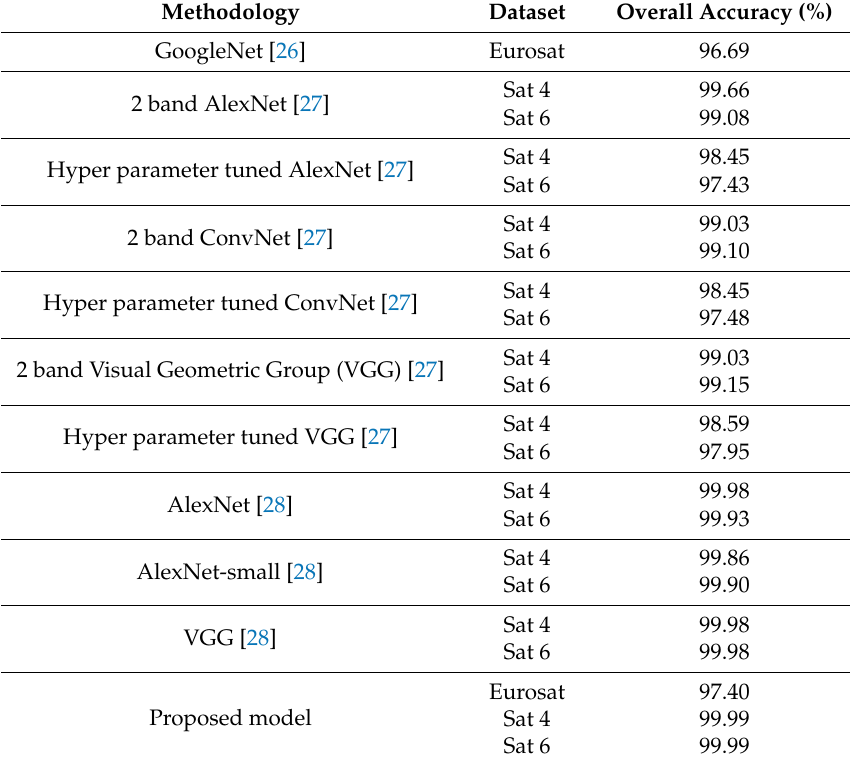
Table 16. Comparative investigation of the proposed and existing